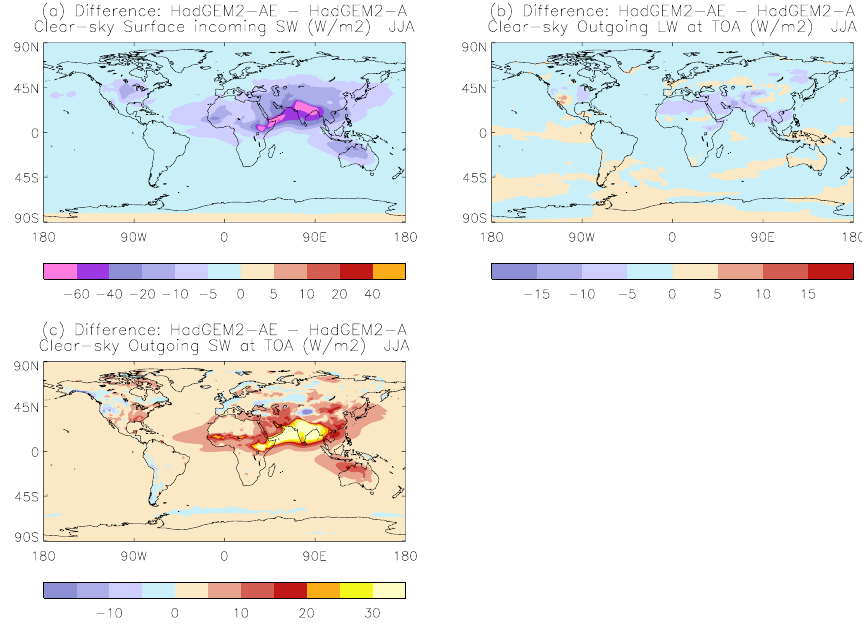
Fig. 7. Clear-sky radiative flux differences (Wm − 2 ) in JJA between HadGEM2-AE and HadGEM2-A runs: (a) surface incoming SW; (b) outgoing LW at TOA; (c) outgoing SW at TOA.